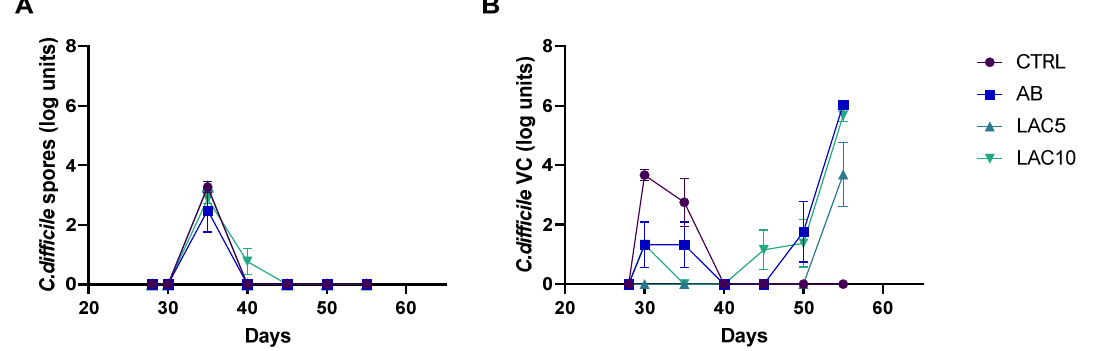
Figure 1. C. difficile spore counts ( A ) and viable cell (VC) counts ( B ) quantified by plating during the course of the control period (C; d28), the clindamycin treatment period (CLI; d30) and the CDI stabilization period (d35–55) of the PathoGut™ SHIME experiment in the distal colon reactors for four of the experimental arms, including arm 1 (CTRL), arm 2 (AB), arm 3 (LAC5) and arm 4 (LAC10). Dots represent mean ± SEM ( n = 3) at different time points of the experiment. Two-way ANOVA was used to calculate statistically significant differences between the experimental test arms, with significance highlighted in the text ( p < 0.05).